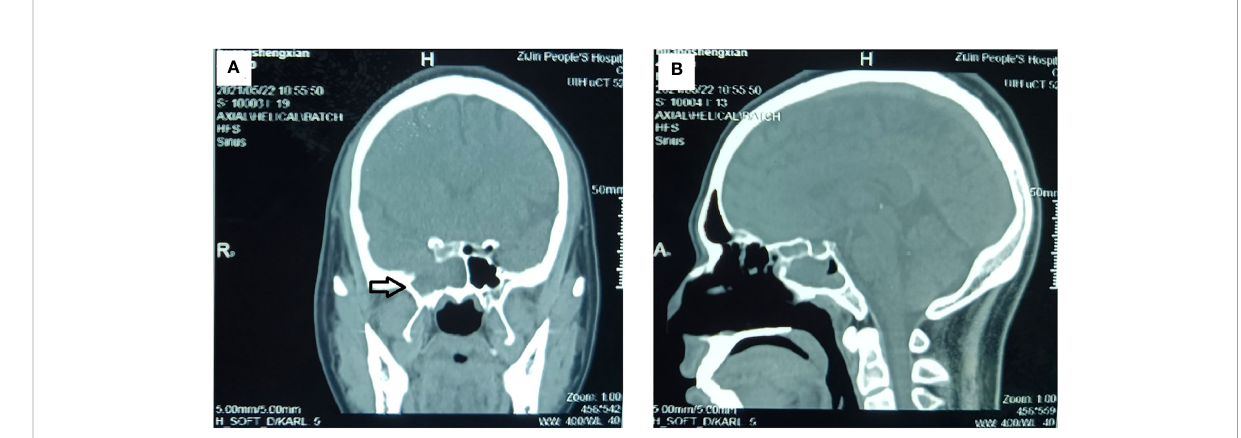
FIGURE 2 Preoperative CT examination of the paranasal sinus. The CT examination showed an inhomogeneous mass in the right sphenoid sinus cavity, and steolytic bone destruction and defect in the parietal wall of sphenoid sinus. (A) Sagittal image and (B) coronal image. (The mass is marked with a black arrow.).